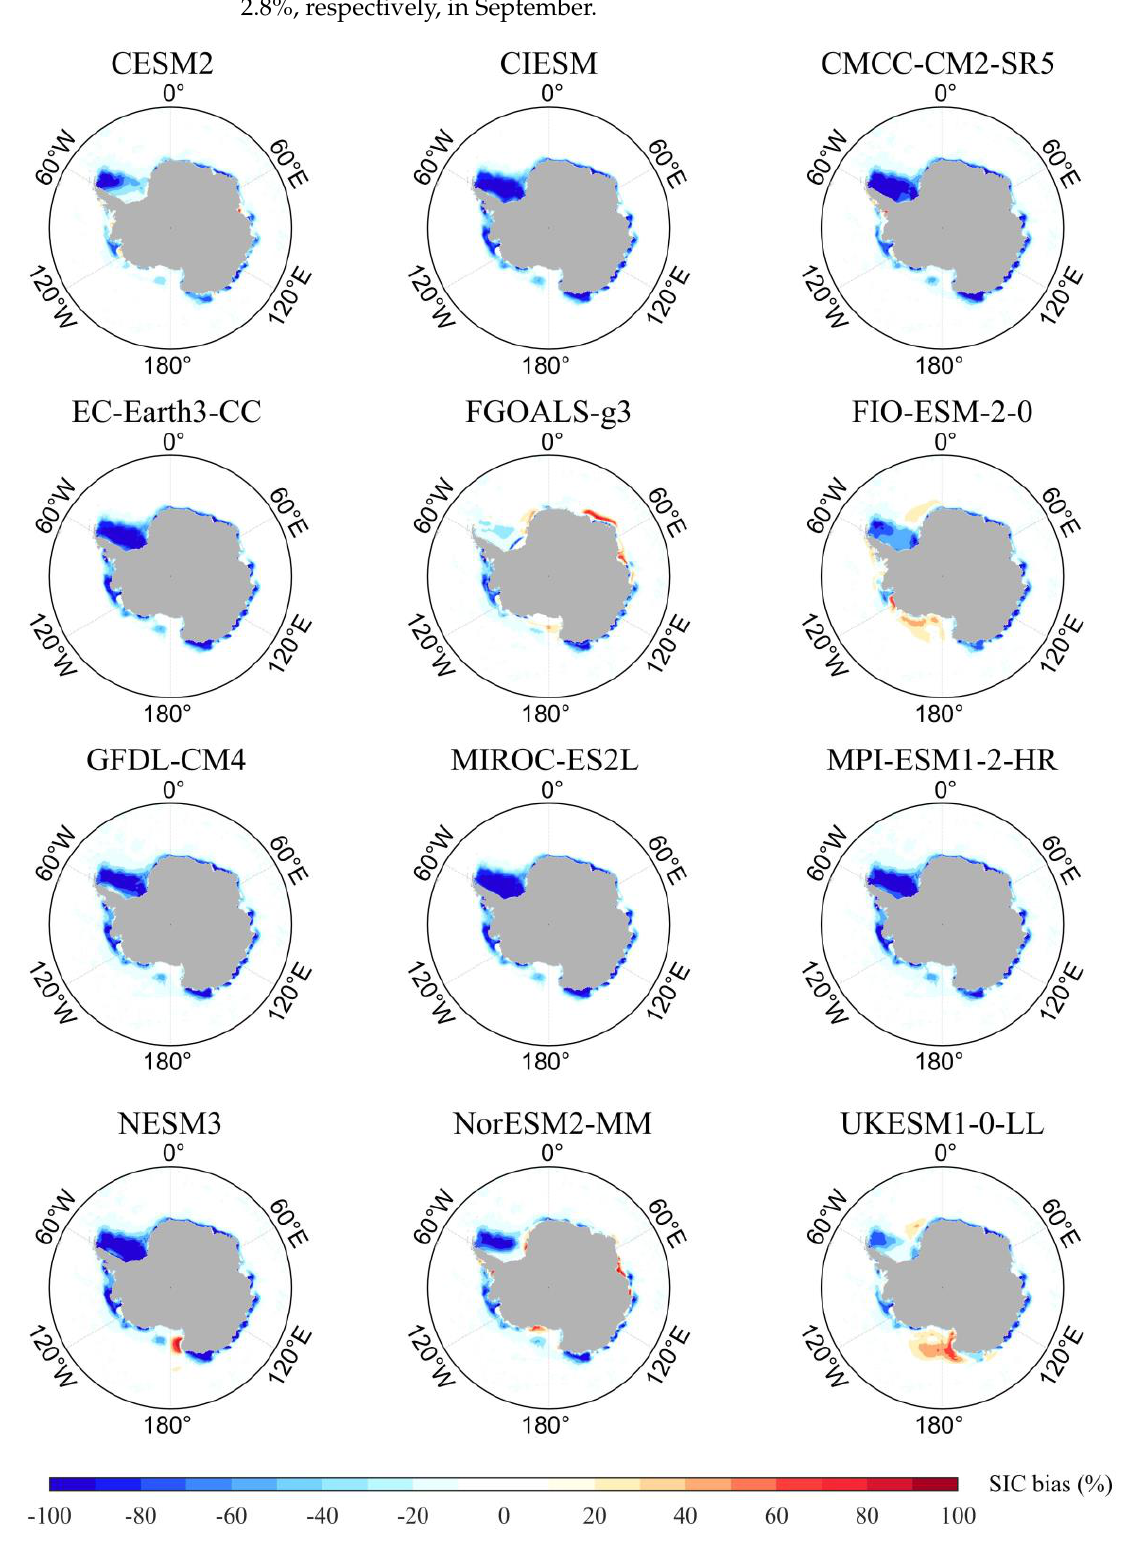
Figure 9. Spatial distributions of multi-year mean SIC difference in February between the CMIP6 models and the observation over the period 2015−2021.